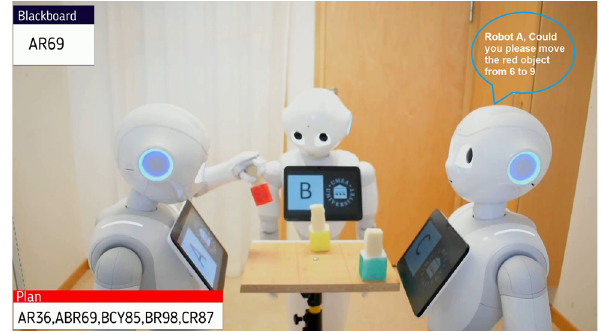
Figure 1: Experimental setup of collaborating Pepper robots moving objects while explaining their own and others ’